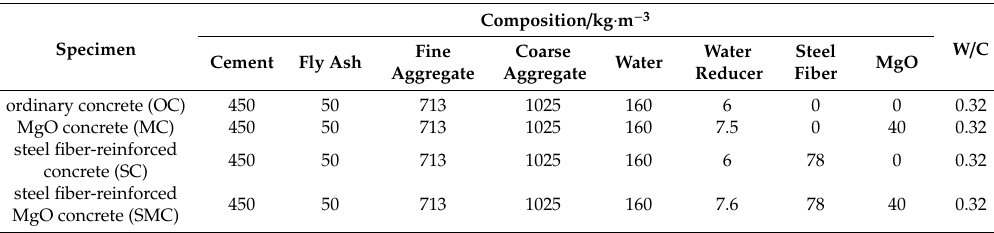
Table 4. Mix proportion of